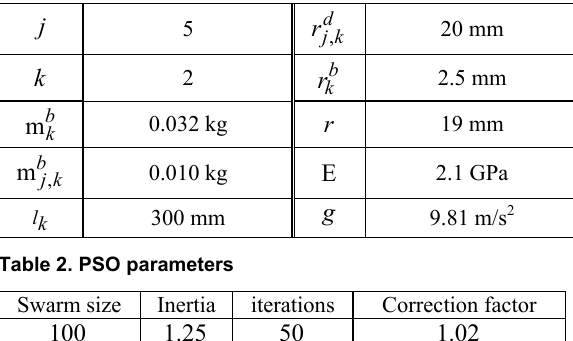
Table 1. Geometrics and material of the simulated CDCR